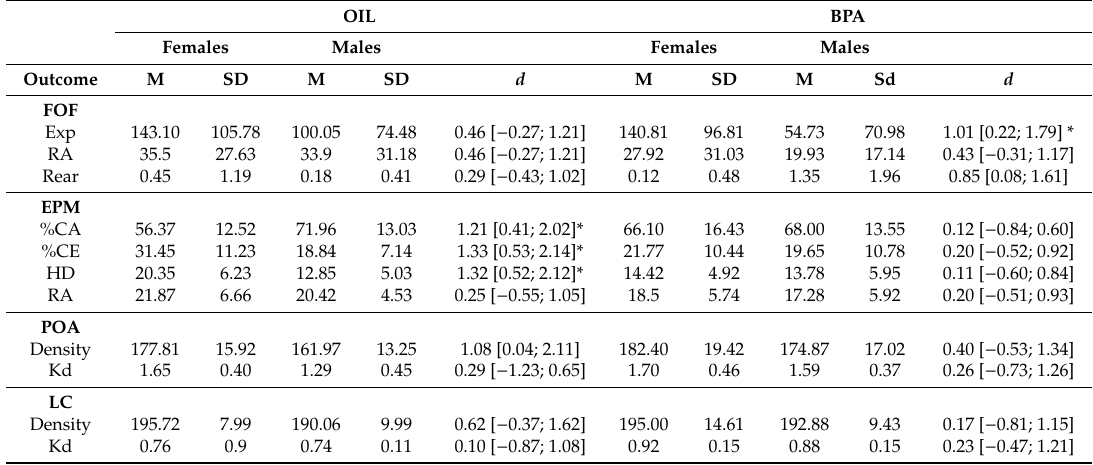
Table 1. Descriptive statistics for each dependent variable in relation to sex and treatment. OIL BPA